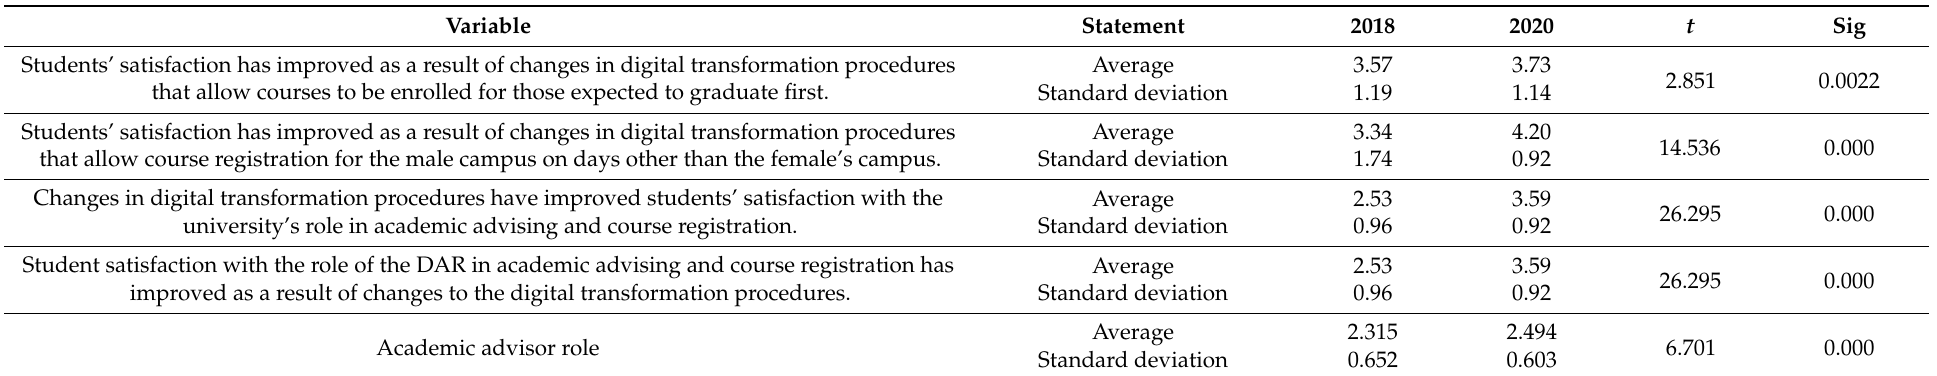
Table 15. t -Test results for the difference between two